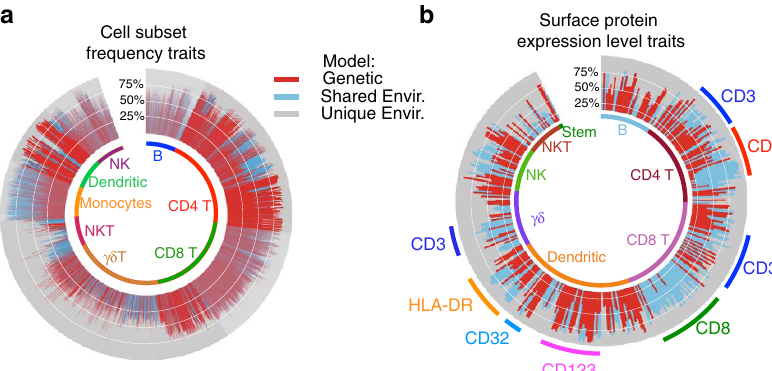
Figure 2 | Proportion of trait variation explained by heritable or environmental influence. Based on SeqM, the fraction of variation in a trait is calculated for heritable, shared environmental or unique environmental factors. This is shown in circle plots for CSF traits ( a ) and SPEL traits ( b ). Traits are arranged in order by the major lineage to which they belong (as indicated inside each circle); for SPEL traits, they were further ordered according to which cell surface protein was quantified (some of which are indicated outside the circle).